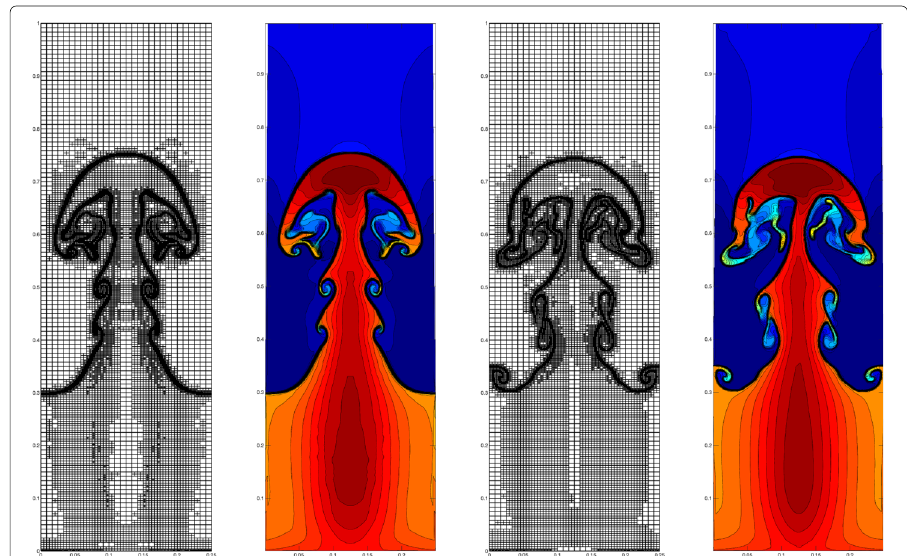
Fig. 16 Euler simulations for Rayleigh-Taylor instability with TVB limiter. From left to right: adaptive mesh for P 1 element; 30 equally spaced density contours from 0.8620 to 2.2407 for P 1 element; adaptive mesh for P 2 element; 30 equally spaced density contours from 0.8705 to 2.2362 for P 2 element